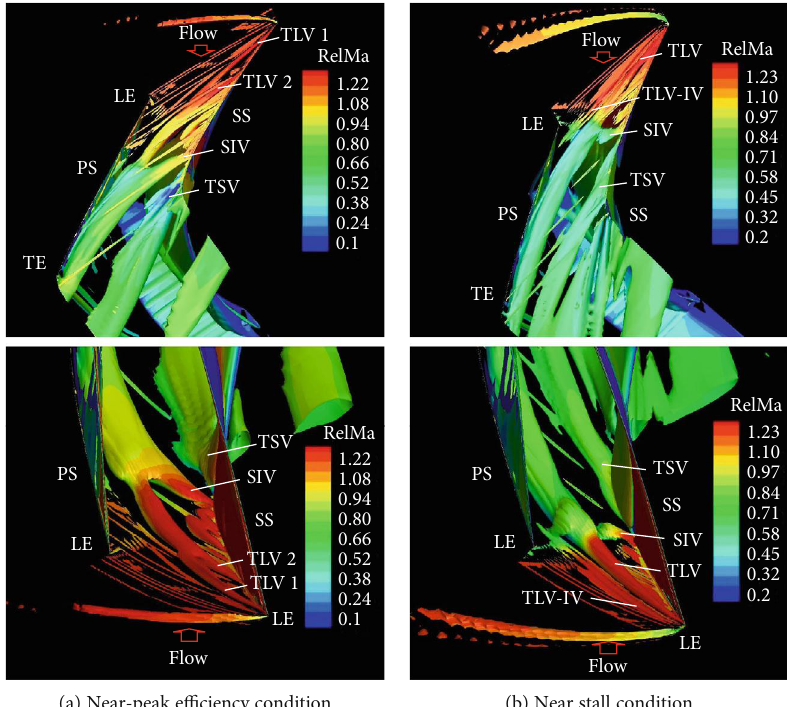
Figure 15: Vortex systems near the blade tip region at near-peak e ffi ciency and near stall conditions for NASA Rotor 67.